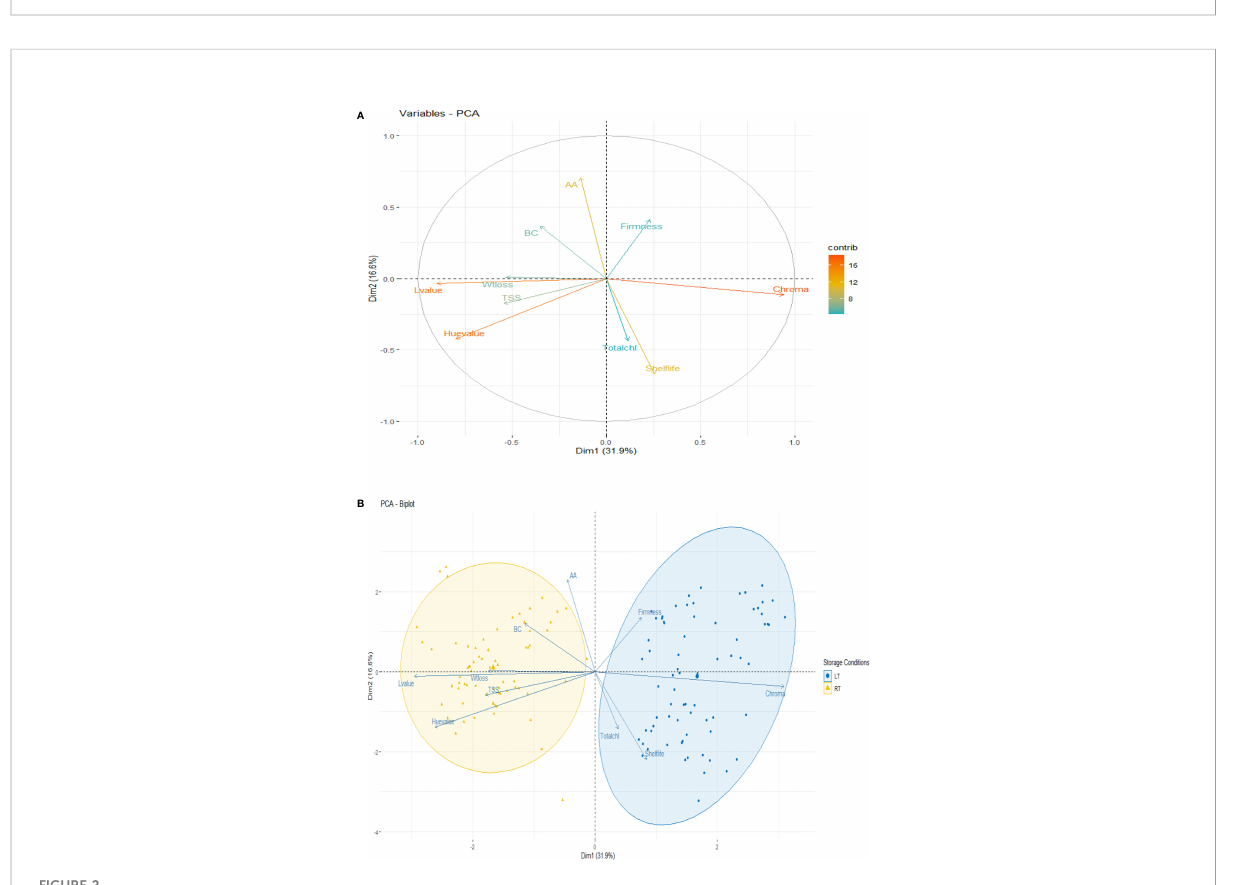
FIGURE 2 Principal component analysis (PCA) of the physiochemical, colorimetric, and nutritional parameters studied for pointed gourd quality storage. (A) PCA of the variables showing their major contribution. (B) PCA – biplot analysis representing the performance of quality parameters at low and room temperature. Wtlos, weight loss; TSS, total soluble solid; Totalchl, total chlorophyll; Lvalue, lightness (L*); Hvalue, Hue (h*); chroma, C*; AA, ascorbic acid; BC, b -carotene; LT, refrigerated at 4°C at 45% RH; RT, room temperature 30 ± 2°C at 65 – 75%